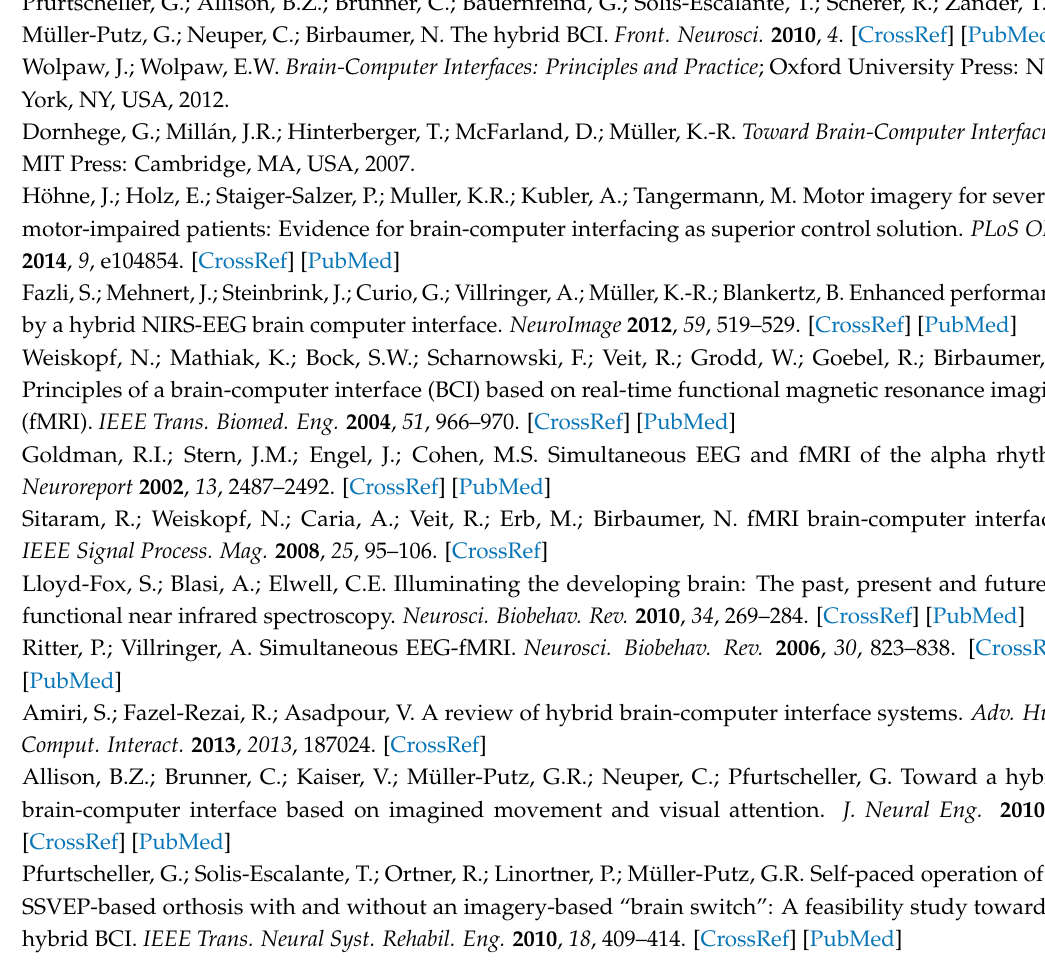
Figure S1: Time courses of concentration changes of ( a ) HbR and ( b ) HbO for mental arithmetic (MA), word chain (WC), and baseline (BL), Figure S2: Classification accuracy for MA vs. BL and WC vs. BL as a function of the number of training